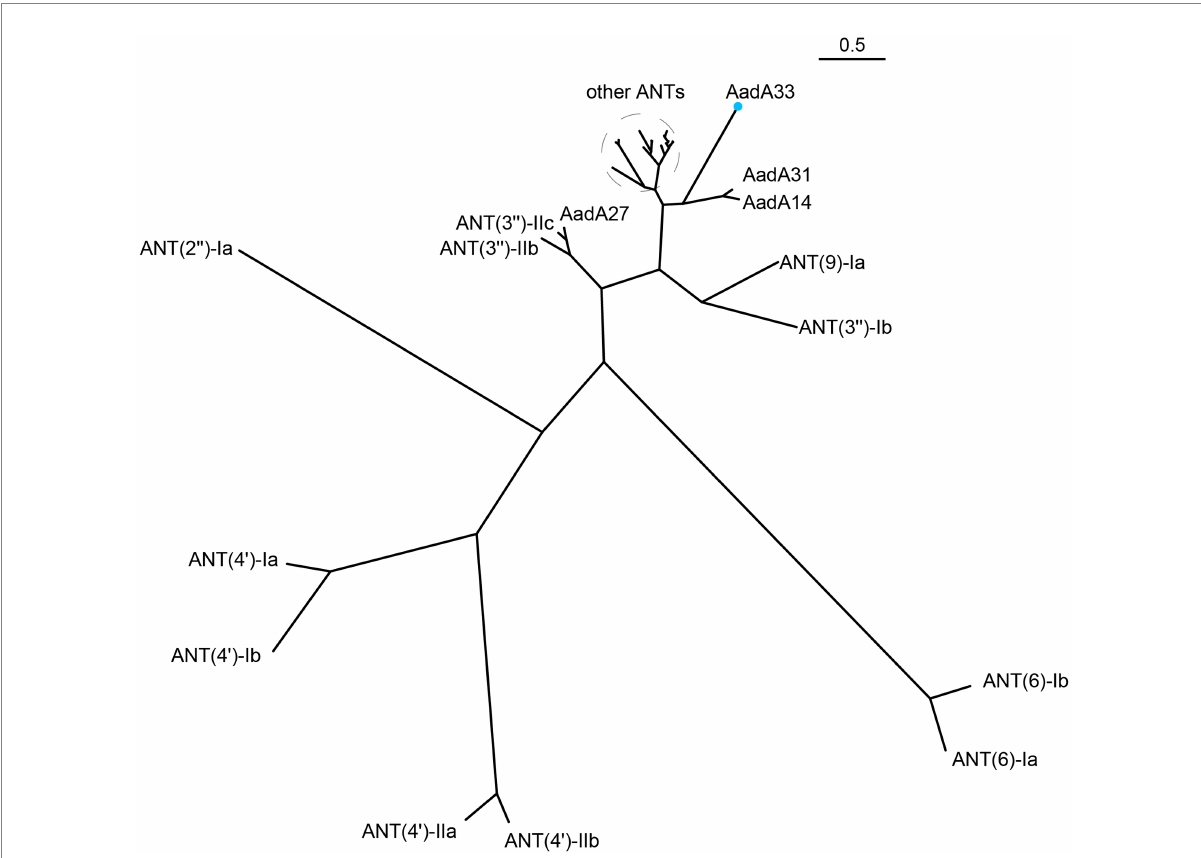
FIGURE 2 A phylogenetic tree showing the relationship of AadA33 with other functionally characterized ANTs. AadA33 is highlighted with a blue dot. Other ANTs include: AadA1, AadA4, AadA5, AadA6, AadA7, AadA8, AadA9, AadA10, AadA11, AadA13, AadA17, AadA21, AadA23, AadA24, AadA25, AadA28, AadA29, AadA30, ANT(3 ″